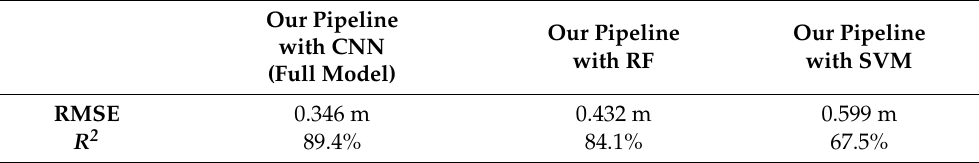
Table 4. Intercomparison of our full pipeline with Random Forests (RF) and Support Vector